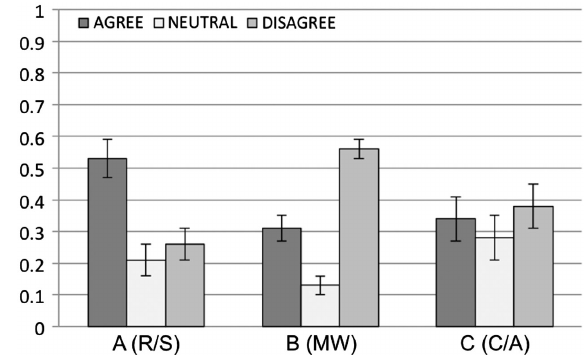
FIG. 3. Postinstruction student responses to the double-slit essay question for courses A , B , and C , where the labels R/S, MW, and C/A refer to the instructional approach of each course, but also to each of the three statements in the essay question for which students expressed a preference. N ¼ 64 ( A ), 133 ( B ), and 46 ( C ); error bars represent the standard error on the proportion.